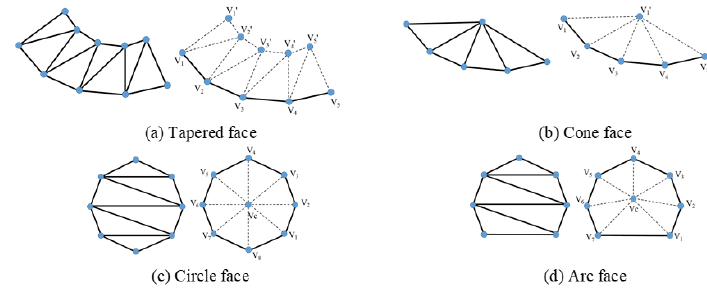
Figure 13. Data size minimization for basic type faces.